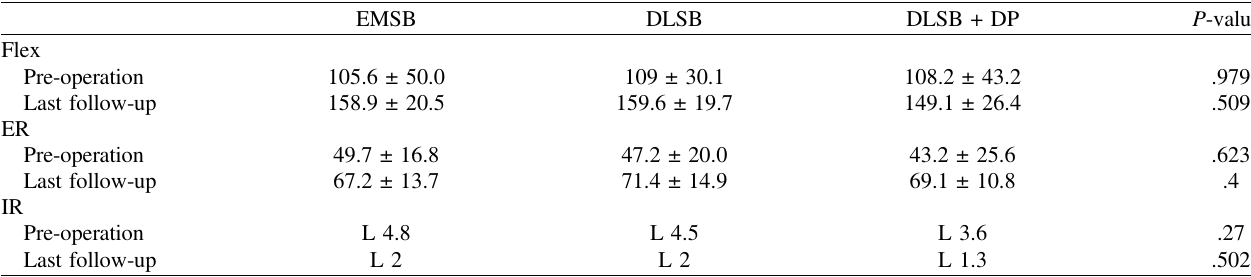
Table 2. Active range of motion before and after